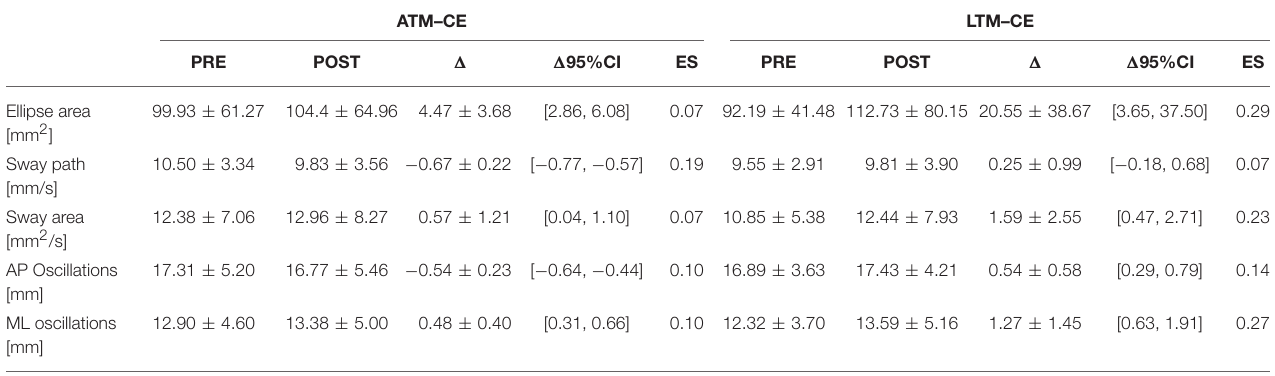
TABLE 2 | Classical postural parameters: comparison between the PRE and the POST values in the CE condition. ATM–CE